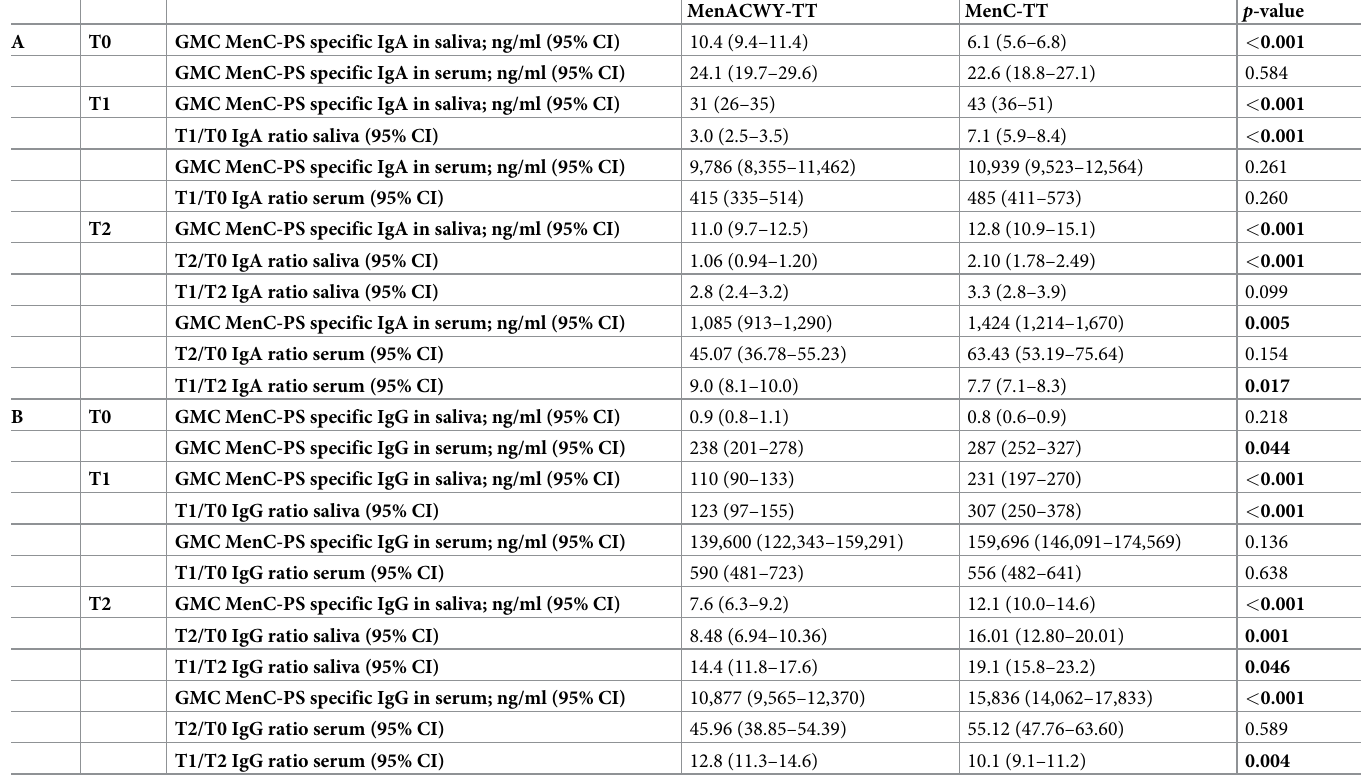
Table 2. Geometric mean concentration (GMC) of meningococcal serogroup C-polysaccharide (MenC-PS) specific IgA (A) and IgG (B) in saliva and serum before (T0), one month (T1) and one year (T2) after adolescent vaccination. MenACWY-TT